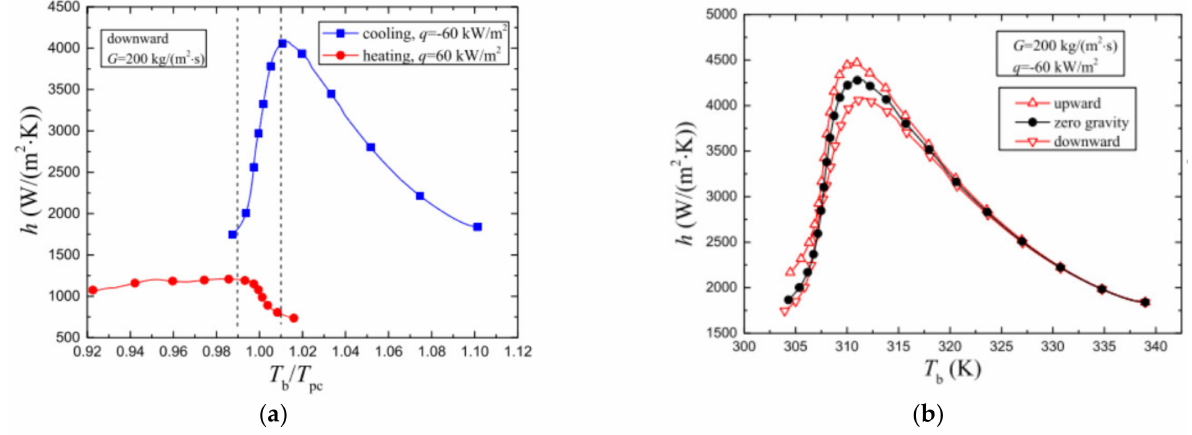
Figure 14. Heat transfer coefficient with various heat fluxes ( a ) and flow directions ( b )